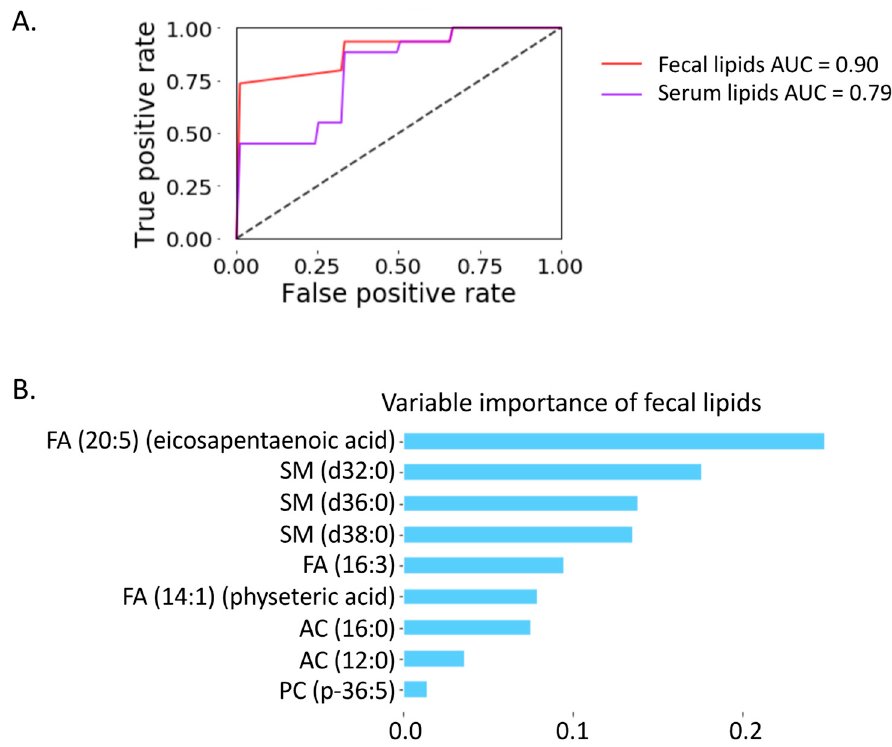
Figure 5. Prediction of progressive liver disease using nine lipid biomarkers. ( A ) Random forest model. Red: nine fecal lipids AUC = 0.90; Purple: nine serum lipids AUC = 0.79. ( B ) Variable im- portance.